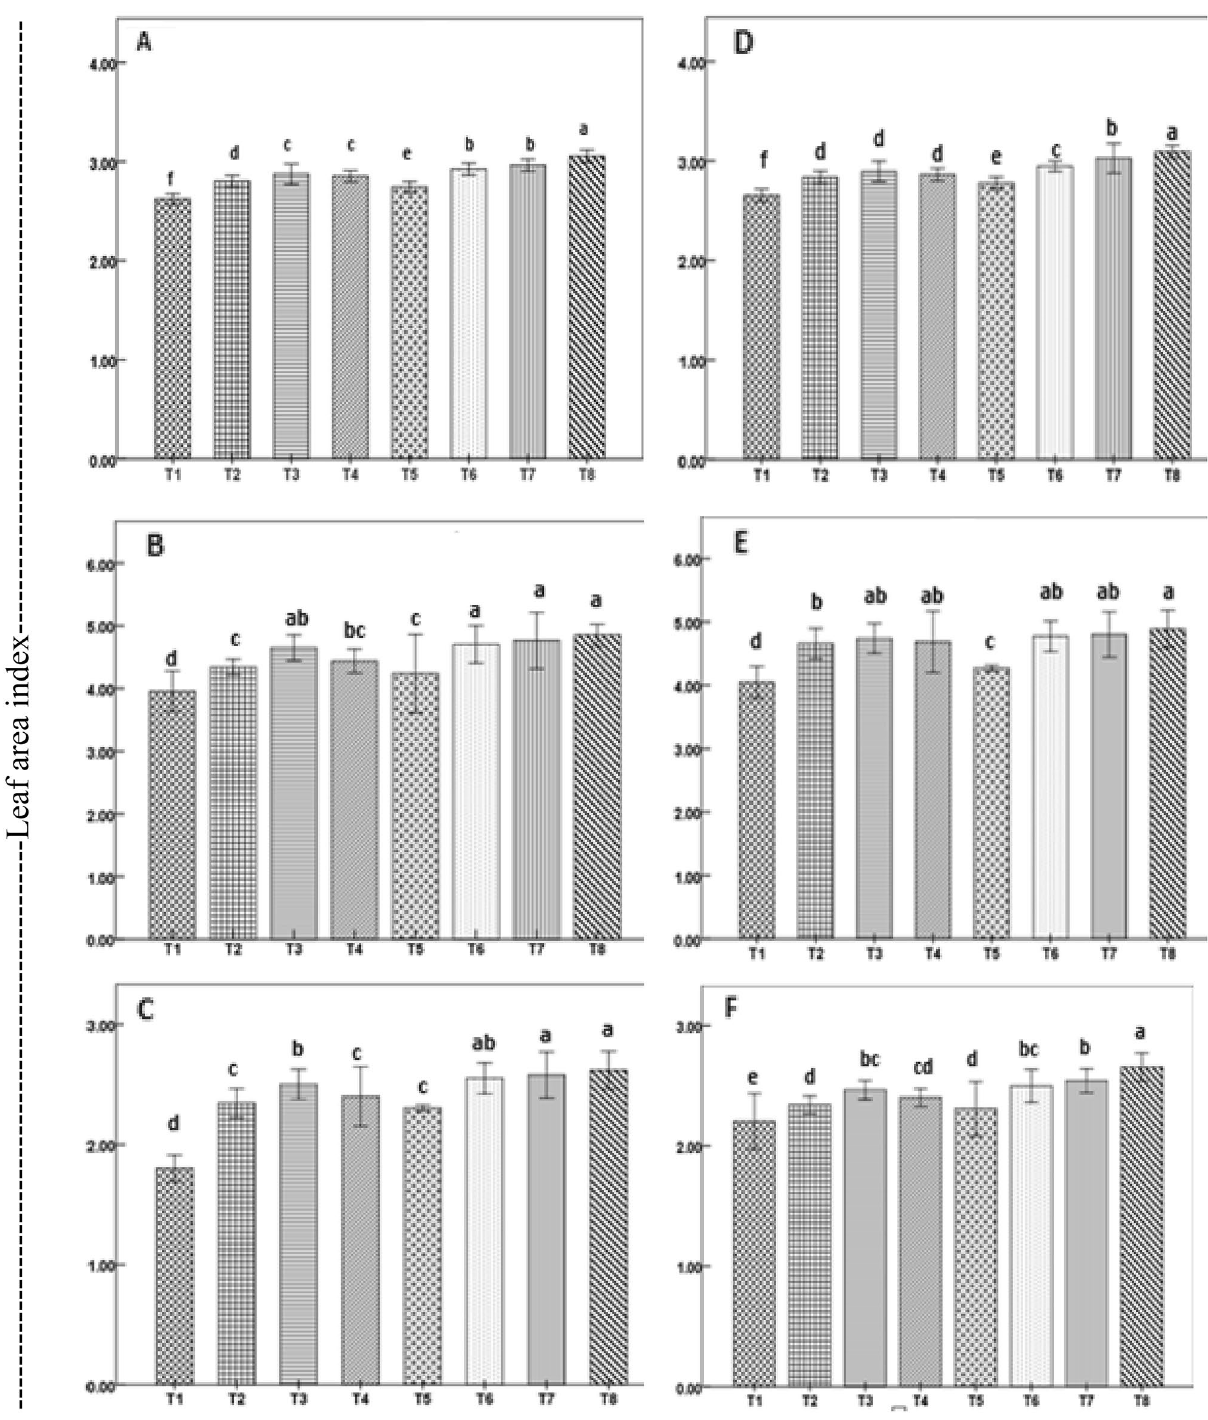
Figure 1. Leaf area index of direct-seeded rice plants during vegetative ( A , D ), reproductive ( B , E ), and ripening ( C , F ) stages as affected by seed priming treatments in a field experiment in 2019 ( A – C ) and 2020 ( D – F ). Treatments with different letters (top of bars) represent significant differences (P < 0.05) between treatments. Vertical lines with caps are ± standard error of the mean. Treatments details are given in Table